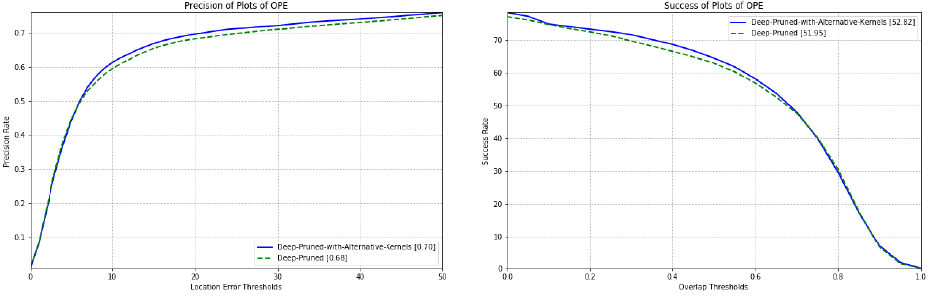
Figure 10. Success and precision plots on OTB2013 dataset with deep-pruned feature network or deep-pruned feature network with alternative kernels. Table 3. AOR and APE, as well as speed of deep-pruned feature network or deep-pruned feature network with alternative kernels, on the OTB2013